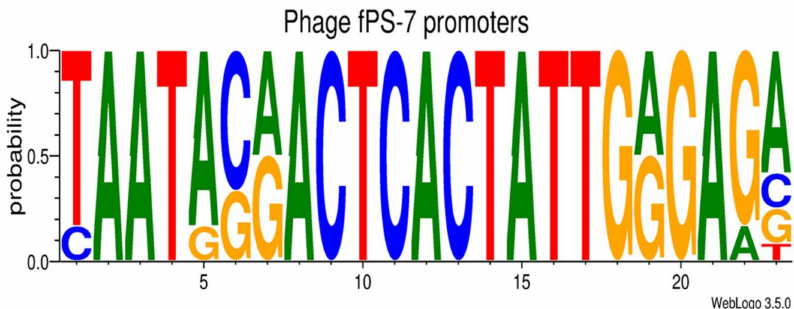
Figure 6. Sequence logo of fPS-7 promoters generated using the sequence logo generator [36] and the data in Table S3. The logo shows the residue probabilities at each